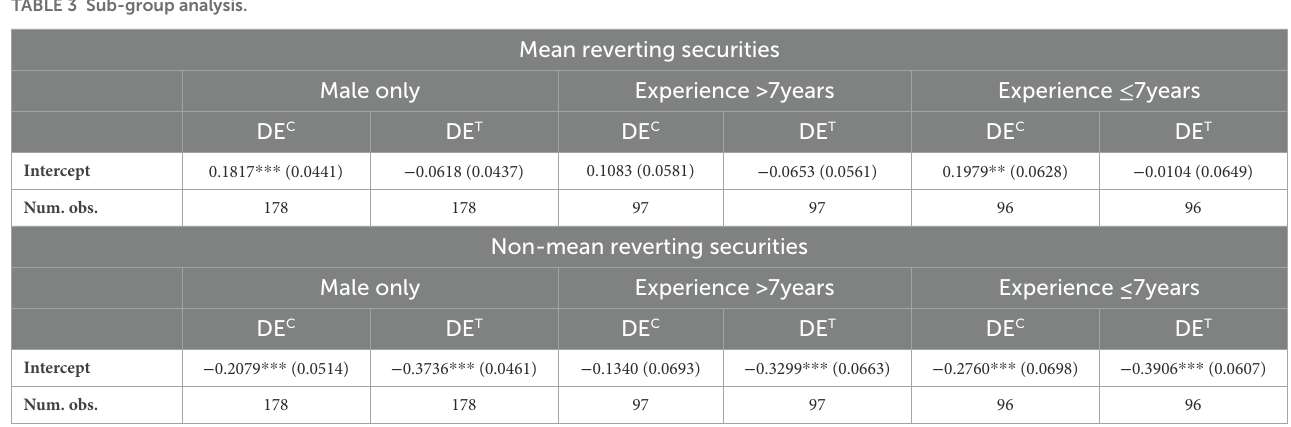
TABLE 3 Sub-group